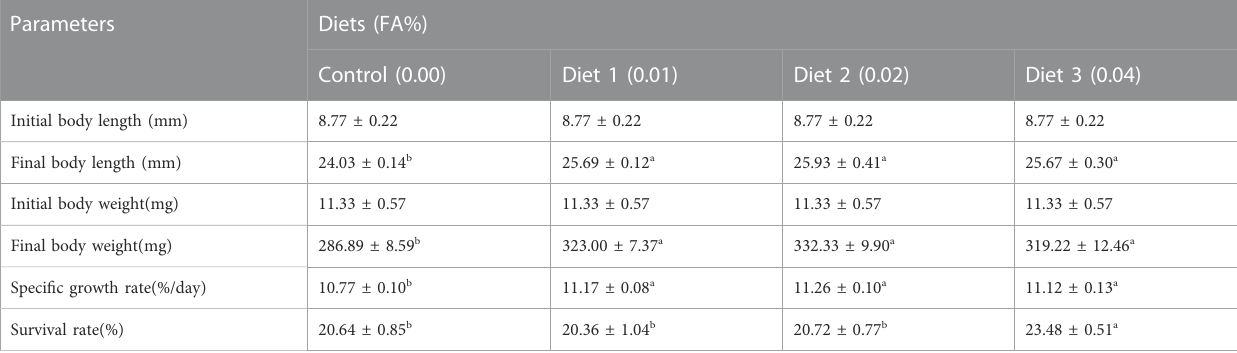
TABLE 3 Effects of supplemental fulvic acid on survival rate and growth performance of large yellow croaker larvae (Means ± S.E.M., n = 3) 1